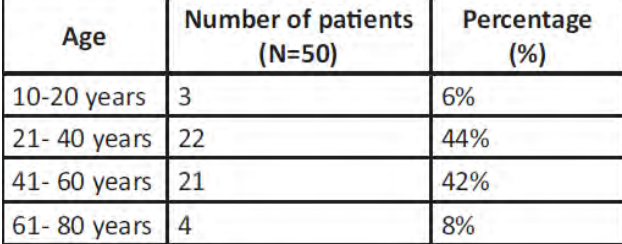
Table 2: Age distribution of patients